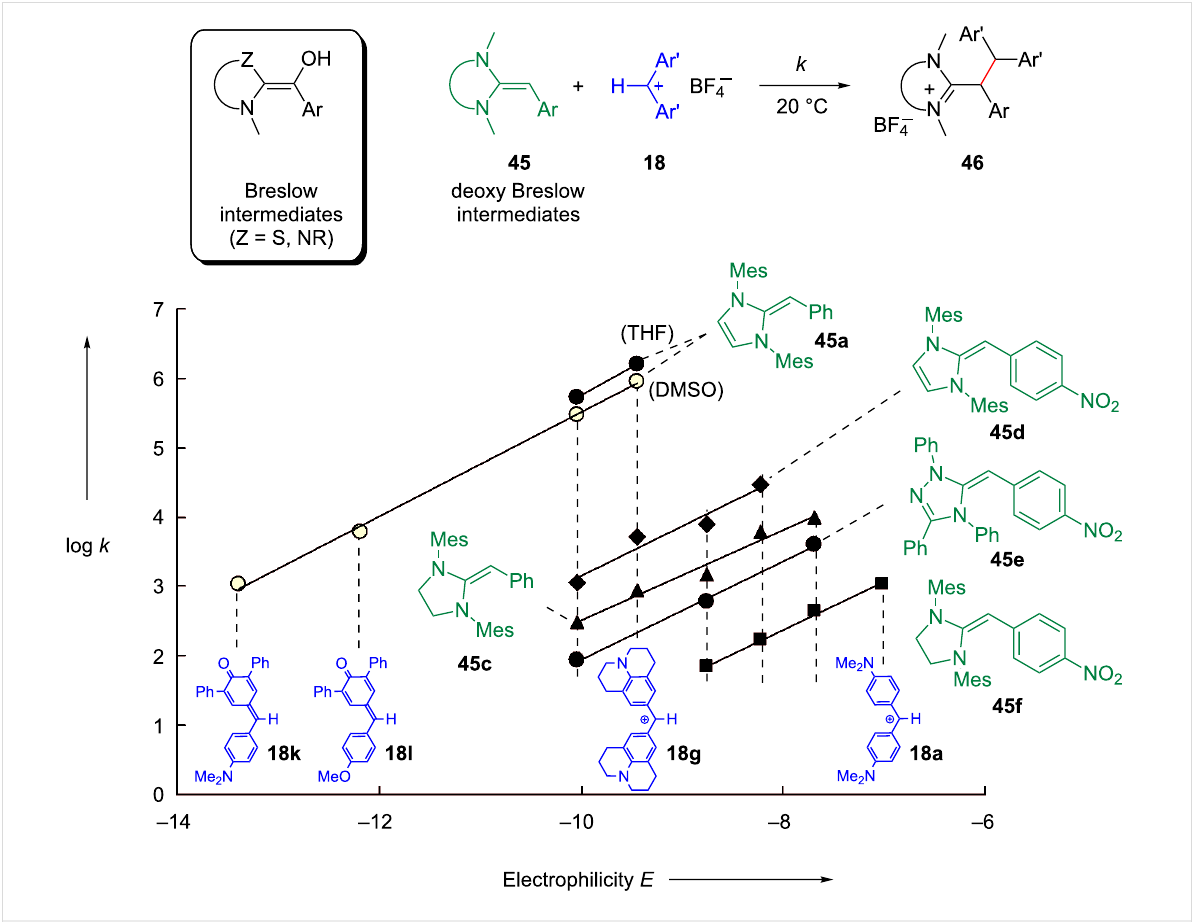
Figure 24: Nucleophilic reactivities of the deoxy Breslow intermediates 45 in THF at 20 °C